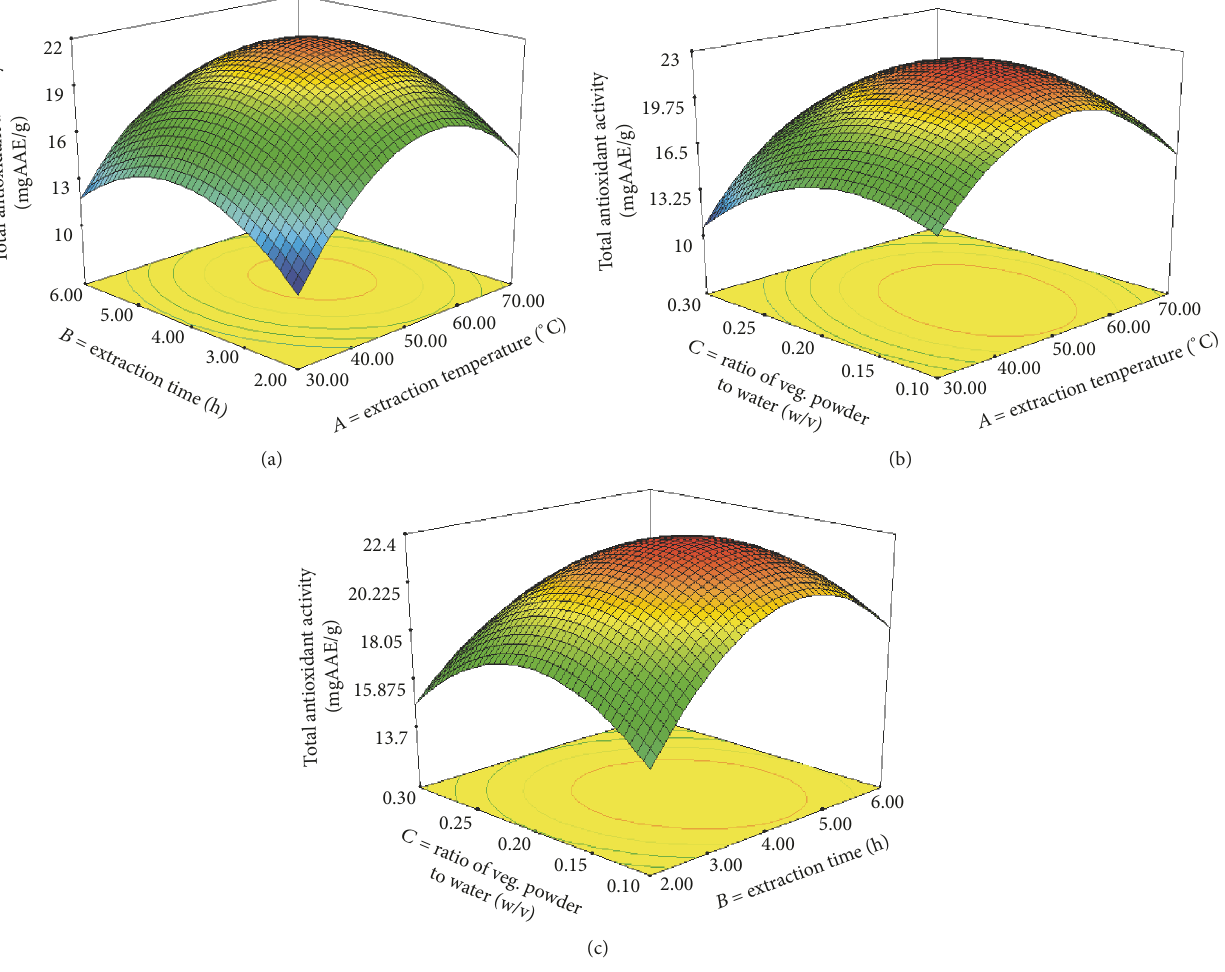
Figure 4: Interaction effects on the total antioxidant activity of Solanum macrocarpon polyphenol concentrates: (a) extraction temperature and extraction time; (b) extraction temperature and vegetable powder : water ratio; (c) extraction time and vegetable powder : water